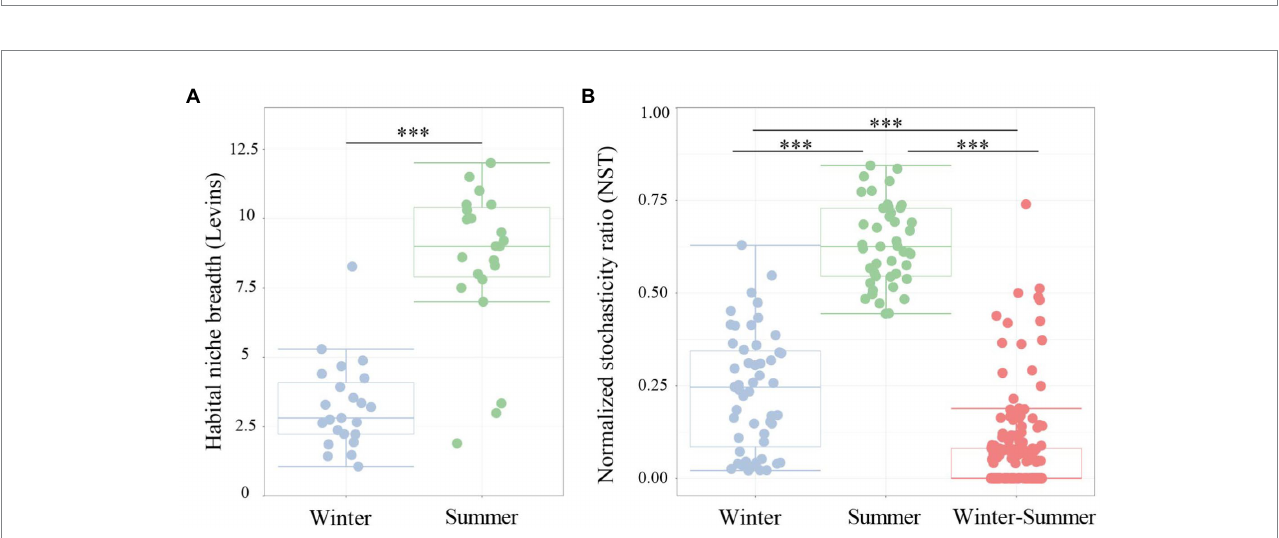
FIGURE 5 Boxplots presenting (A) the mean habitat niche breadth and (B) the ratio of stochasticity in bacterial community assembly from water samples of subsidence lake and natural river in different seasons. Two comparisons with Wilcoxon tests, * p < 0.05, ** p < 0.01, *** p <